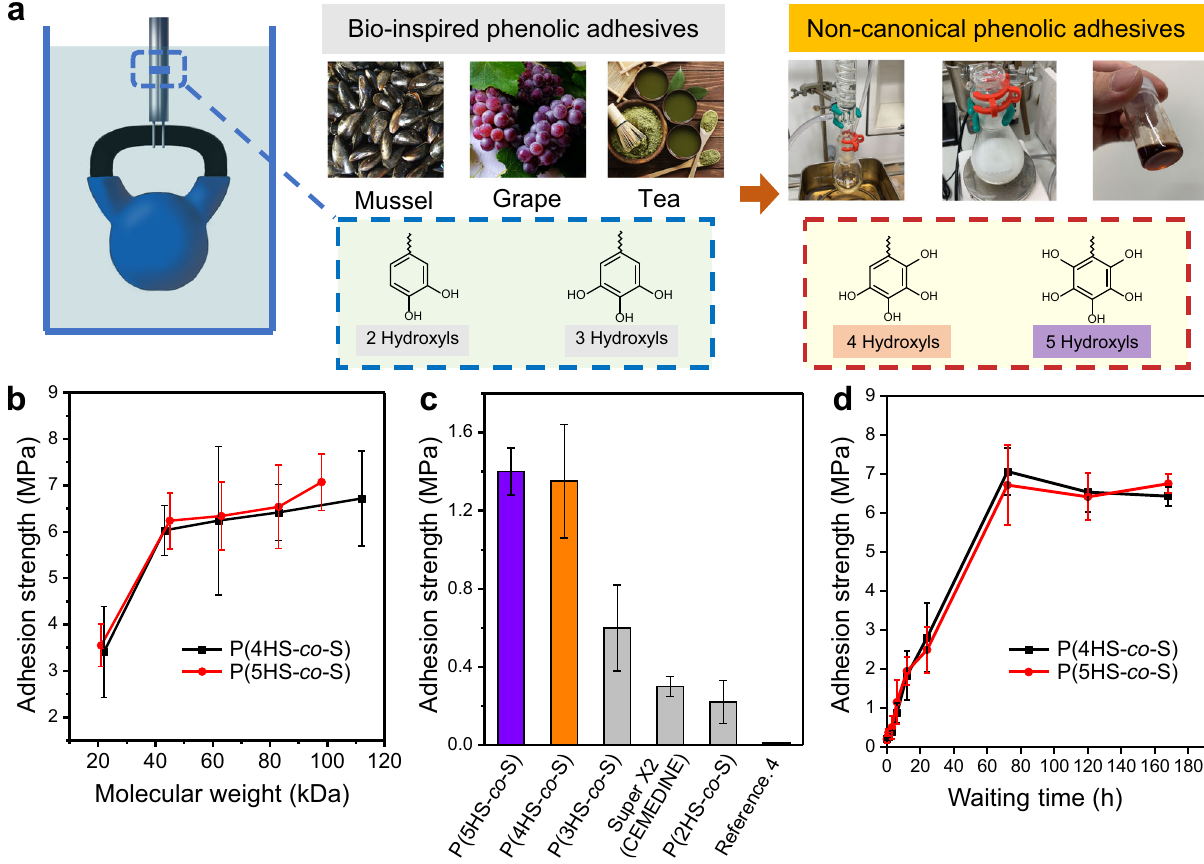
Fig. 1 Synthesis and performance of phenolic underwater adhesives. a Comparison of bio-inspired (catechol and gallol) phenolic adhesives to non- canonical (4 and 5 hydroxyl residue) phenolic adhesives. b M n dependence of adhesion for P(4HS -co -S) and P(5HS -co -S). The results represent the mean ± s.d. ( n = 5). c Adhesion strengths of different adhesives with optimized M n on steel after waiting for 10 s. The results represent the mean ± s.d. ( n = 5). d Waiting time dependence of adhesion strengths of P(4HS -co -S) and P(5HS -co -S). The results represent the mean ± s.d. ( n =